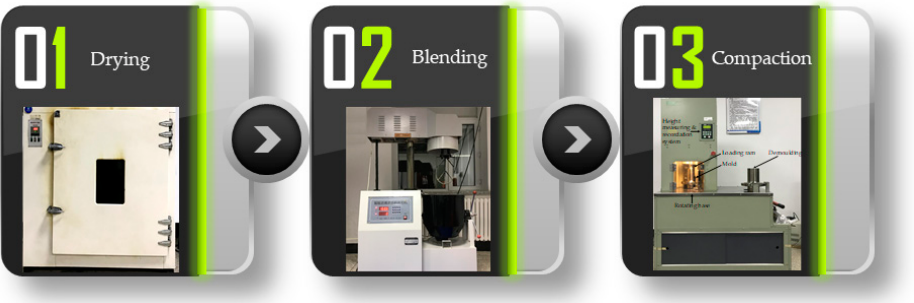
Figure 1. Gradation of stone mastic asphalt (SMA)-13.